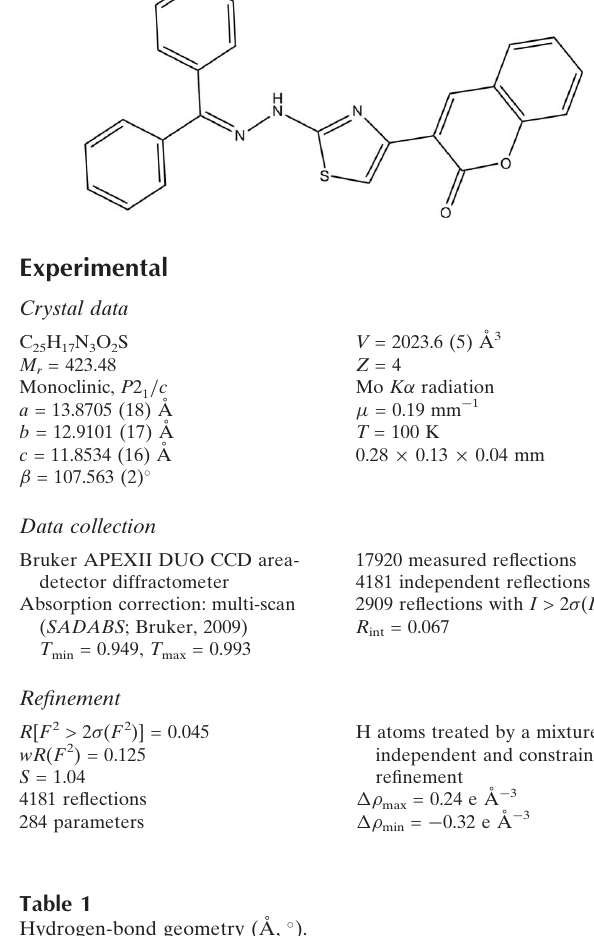
Hydrogen-bond geometry (A˚ , (cid:3) ). Cg 1 and Cg 2 are the centroids of the C14–C19 and C2–C7 benzene rings,